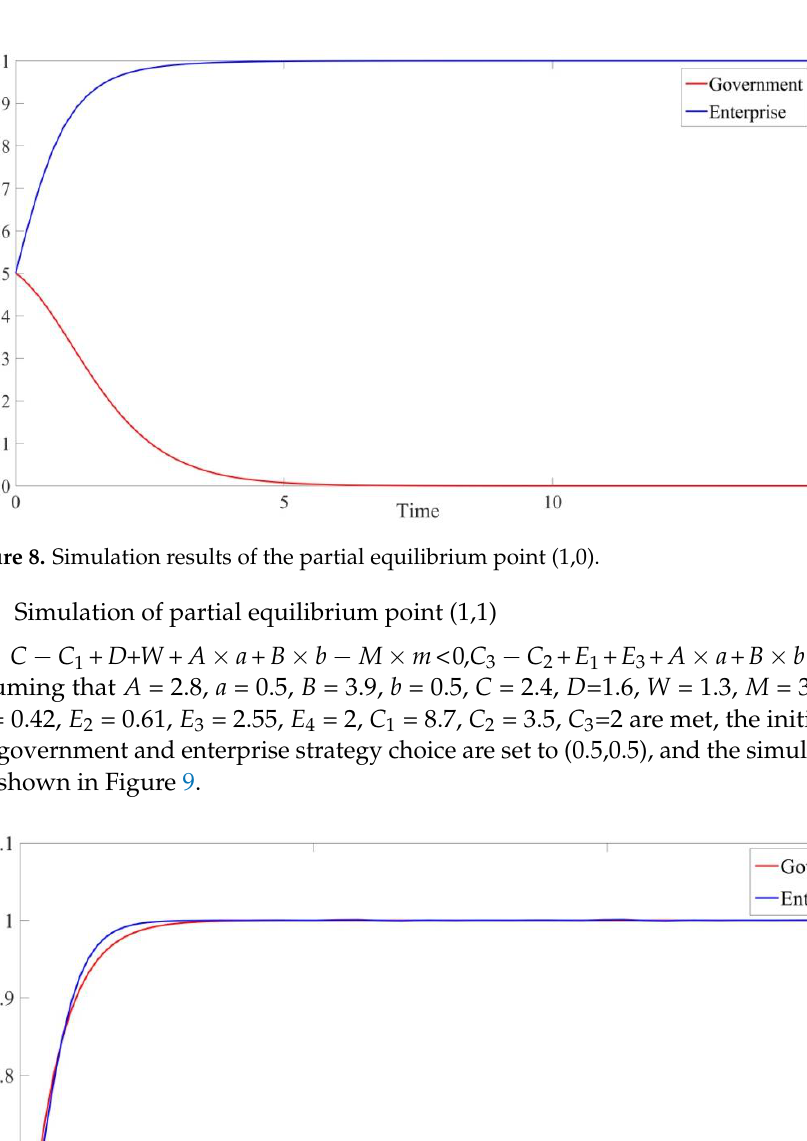
19 Figure 7. Simulation results of the partial equilibrium point (0,1). According to the simulation results, in this case, the system converges to point (0,1), which is consistent with the above-mentioned evolutionary stability strategy analysis. When the investment in supporting enterprises to participate in cross-border e-commerce B2B export trading is less than the social loss caused by adopting the “ ig- nore ” strategy, the government will continue to choose the “ support ” strategy. Whileenterprises can obtain government support, the cost of their participation is still too high. Therefore, they are less enthusiastic about the participation and will finally, give up participating in the business. At this time, the evolutionary stabilization strategy of the government and enterprises is (support, not participate). (3) Simulation of partial equilibrium point (1,0)